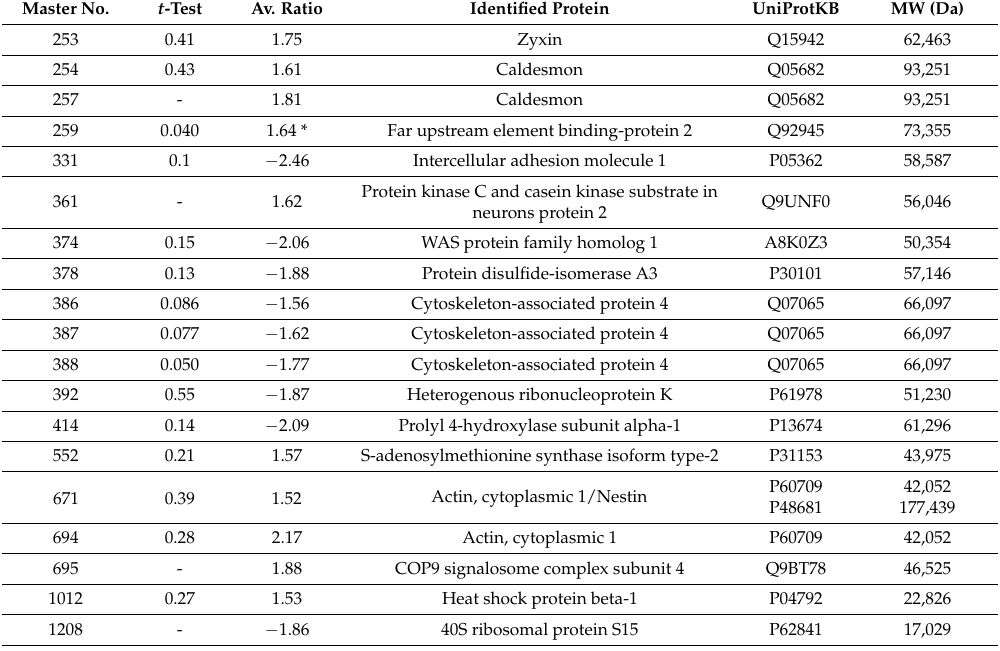
Table 2. Differentially expressed proteins in CXCL-8 treated, preinflamed, heparinase III and chondroitinase ABC treated HMVEC identified by